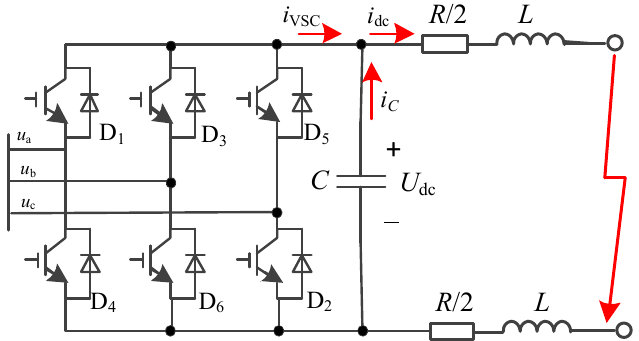
Figure 3. Equivalent circuit of voltage source converter (VSC) during a pole-to-pole fault.